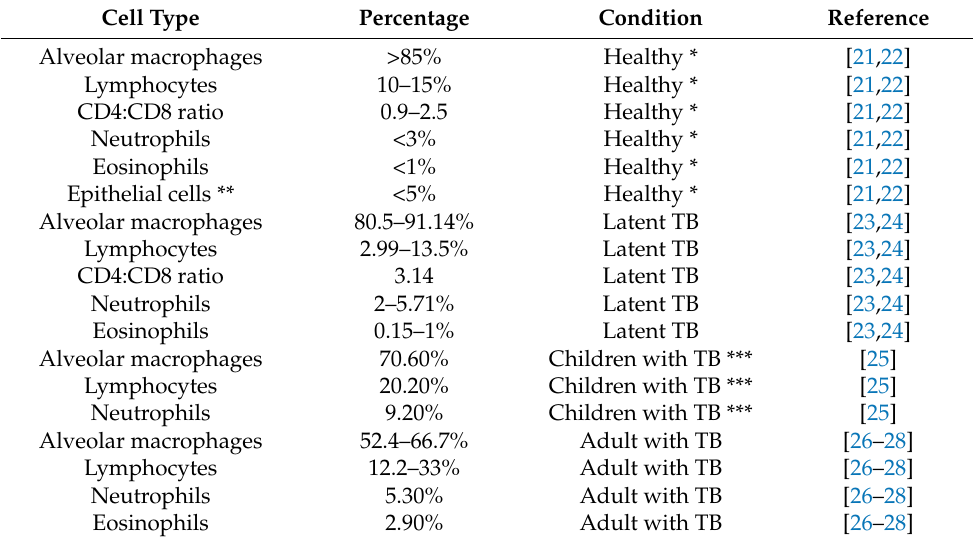
Table 1. Cellular composition of BALF from healthy subjects, children, and adult patients with latent and active TB. Cell Type Percentage Condition Reference Alveolar macrophages